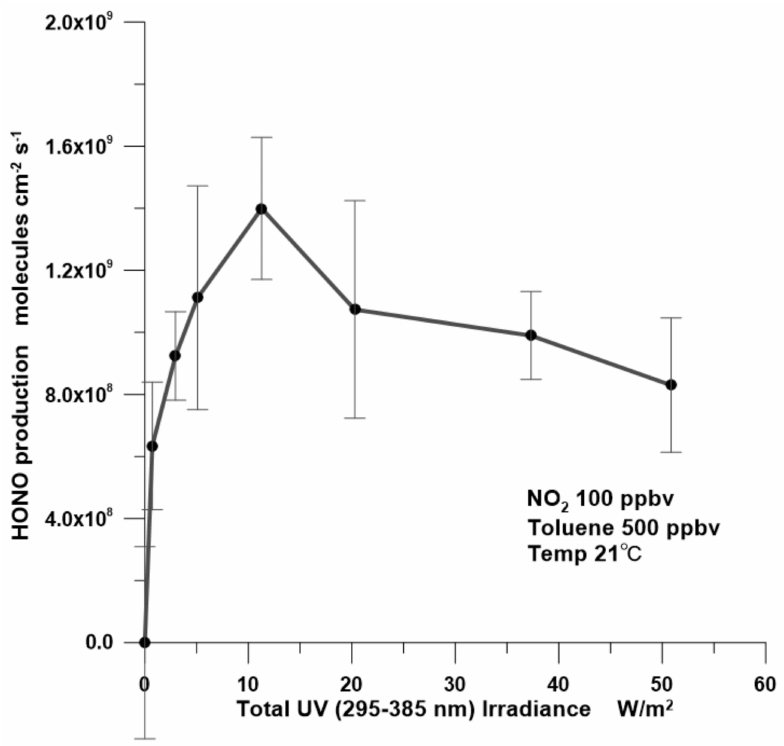
Figure 2. HONO production rate as a function of total UV irradiance. Input concentrations of NO 2 and toluene were fixed as 100 ppbv and 500 ppbv,